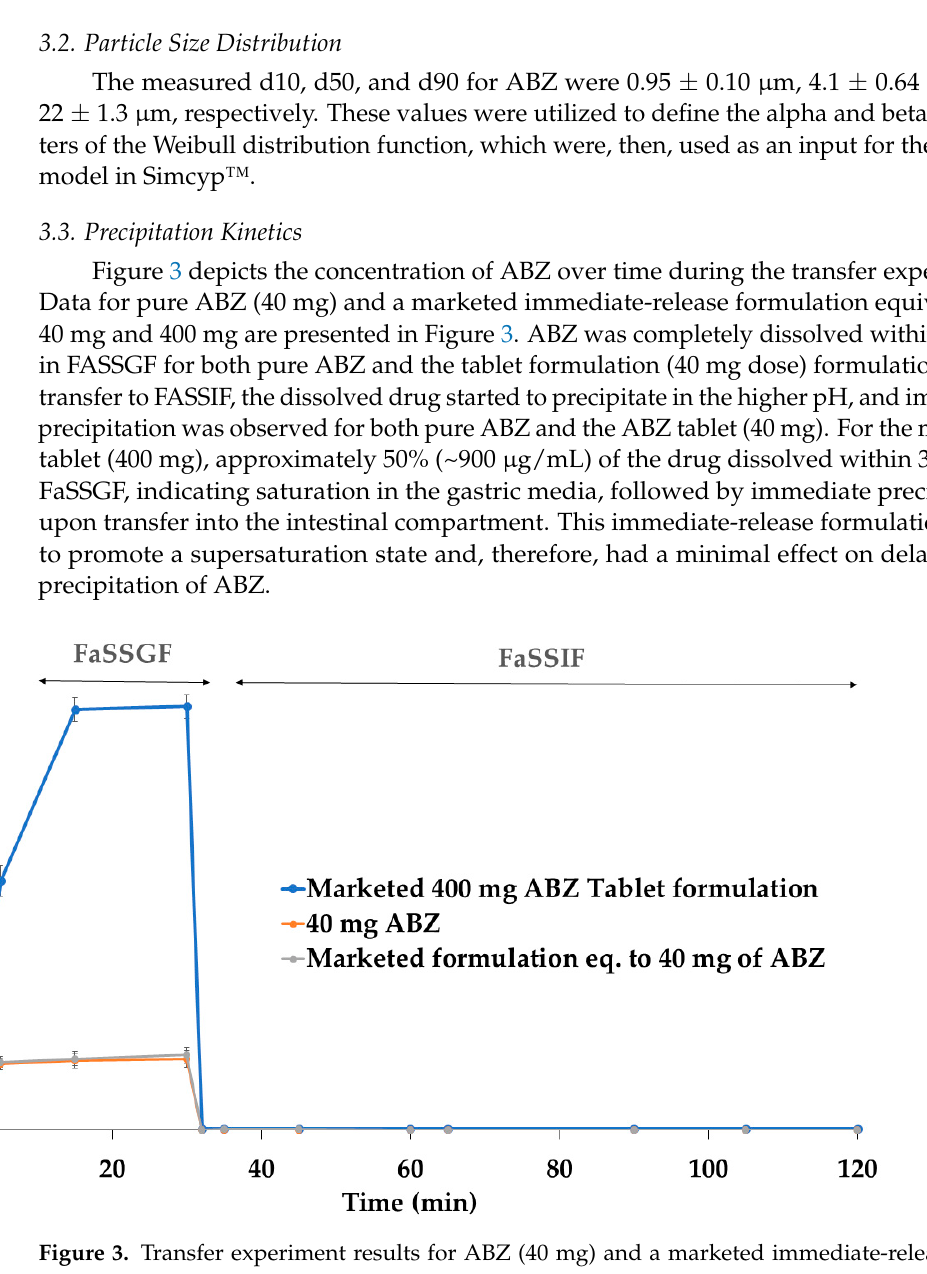
Table 2. Measured solubility profile of pure ABZ in various pH systems and biorelevant media at 37 ± 2.0 ◦ C.